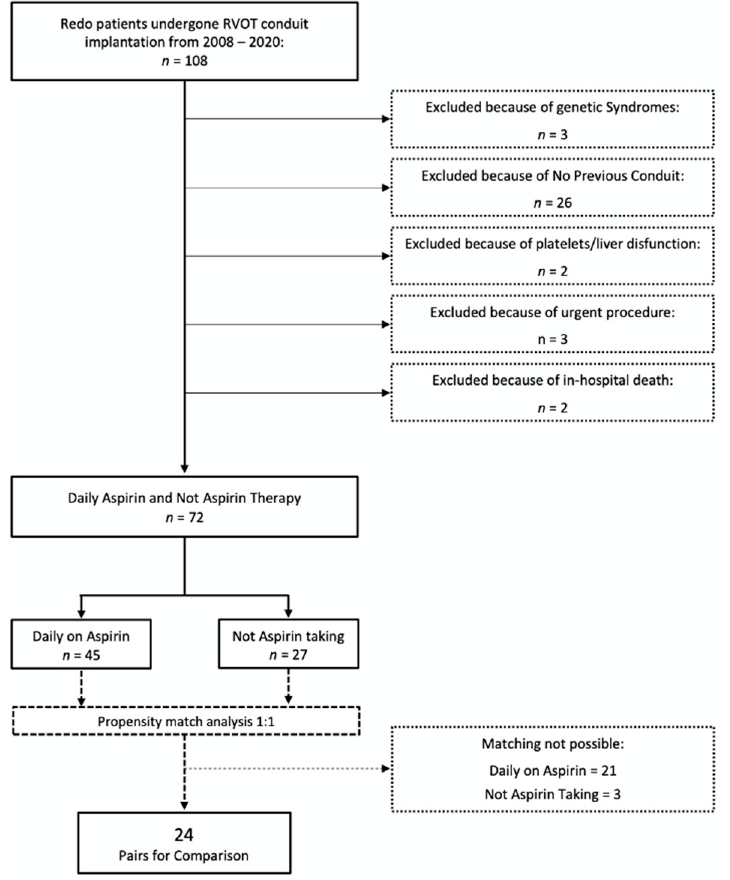
Figure 1. Study Design. RVOT: right ventricle outflow tract